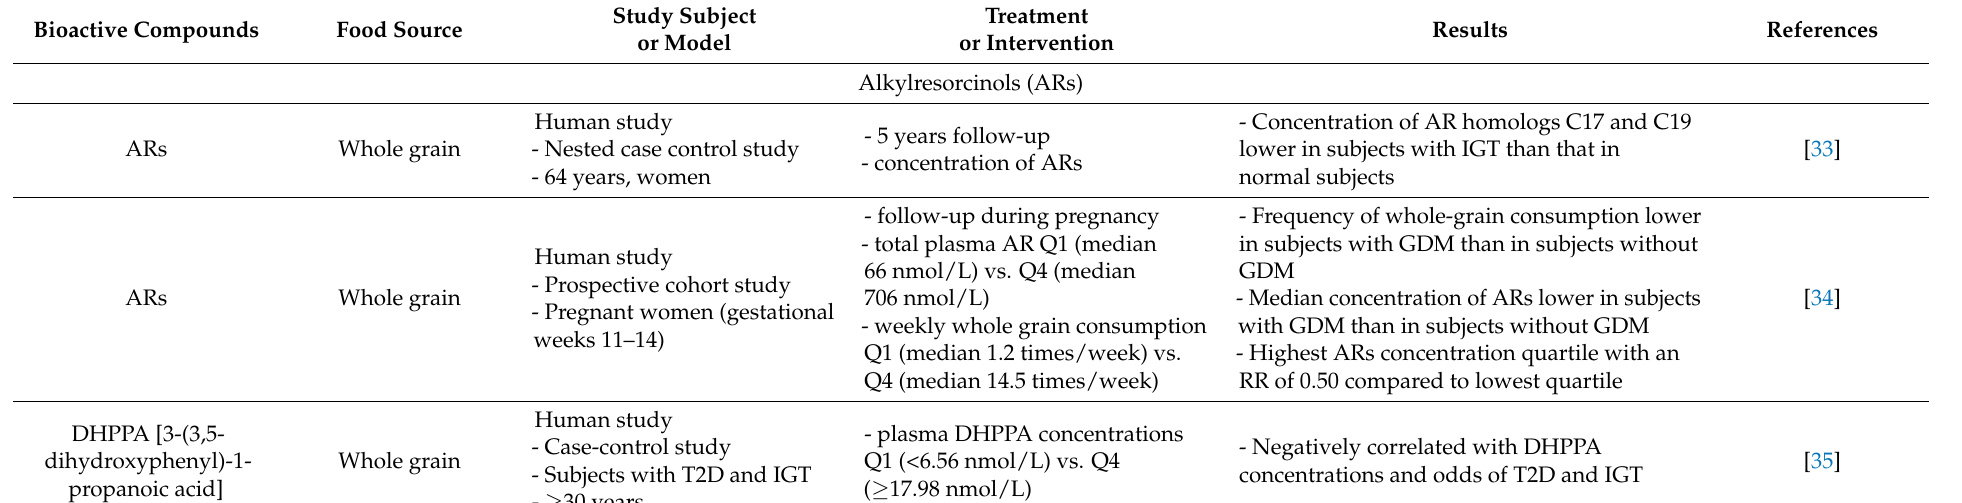
Table 1. Effects of phenolic compounds on cardiovascular and metabolic